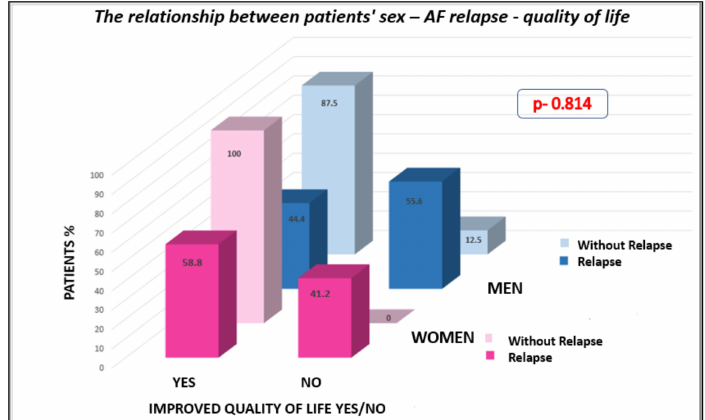
Figure 7. The relationship regarding the quality of life and the presence of relapse 3 months after the procedure, depending on the patient’s